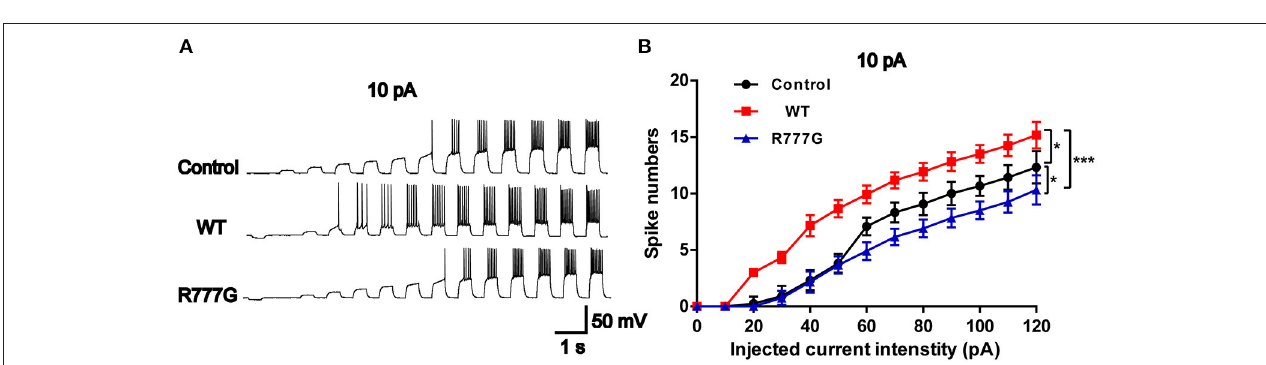
FIGURE 4 | CNTNAP2 R777G impairs the action potentials of neurons. (A) The sequential sweeps of APs in different groups evoked with different intensity of injected currents. (B) Evoked action potentials were quantified to compare the neuronal excitability in different groups. n = 4 or 5 for each group. ANOVA and Bonferroni’s post-hoc test, * p < 0.05, *** p <